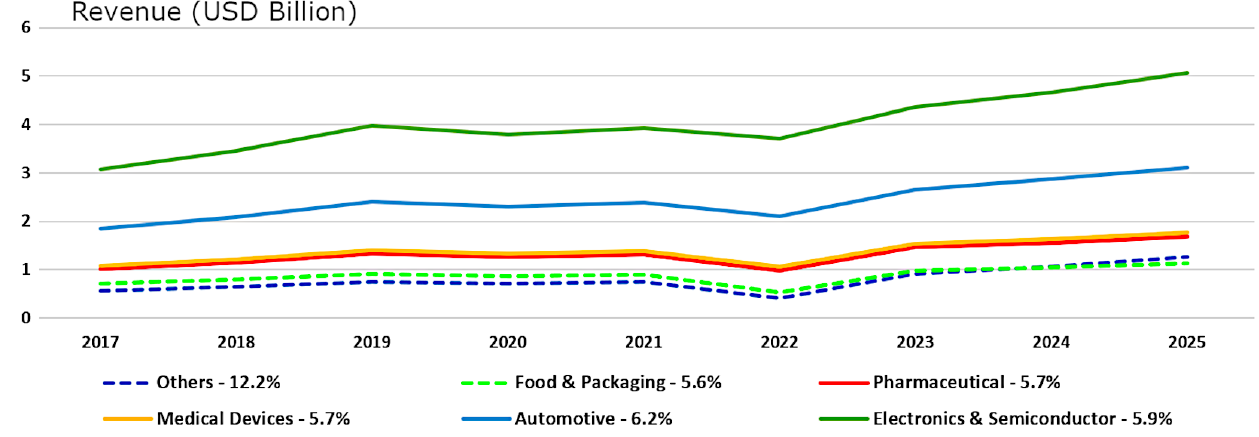
Figure 2. Analyses and revenue forecasts related to vision system implementations by industry tak-